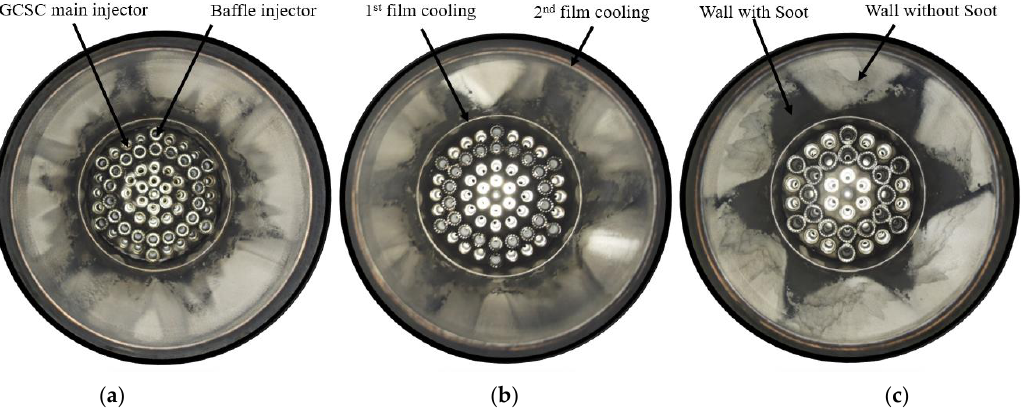
Figure 12. Internal wall of combustion chamber after combustion tests; ( a ) GCSC-A ( b ) GCSC-B ( c ) GCSC-C.